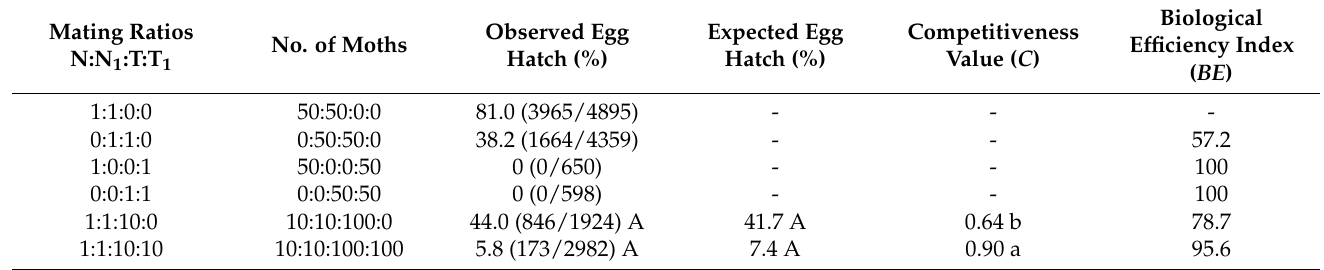
The treatment was repeated three times. Numbers between parenthesis are hatched eggs/total laid eggs. Percent- ages in rows followed by the same uppercase letter are not significantly different ( p ≤ 0.05, Z test); Percentages in columns followed by the same lowercase letter are not significantly different ( p ≤ 0.05, Z